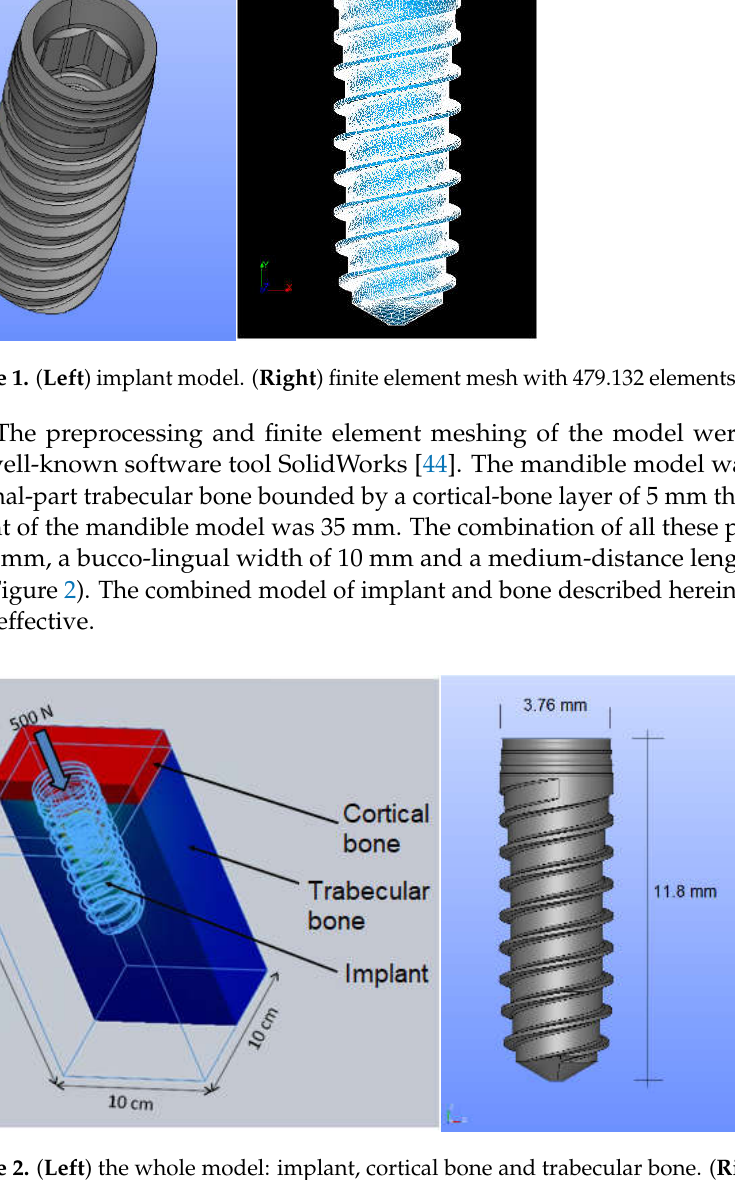
Figure 2. ( Left ) the whole model: implant, cortical bone and trabecular bone. ( Right ) implant.